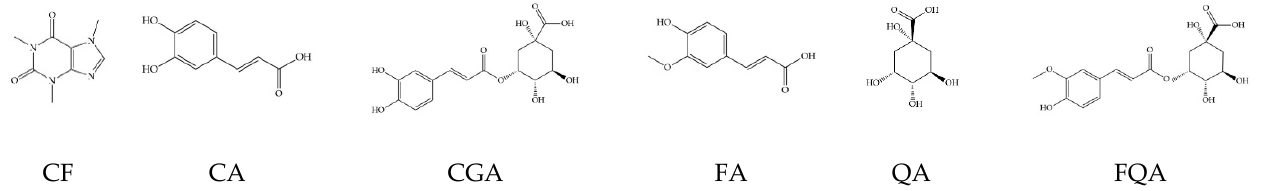
Figure 1. Chemical structures of caffeine (CF), caffeic acid (CA), chlorogenic acid (CGA), ferulic acid (FA), quinic acid (QA), and feruloylquinic acid (FQA) present in coffee [2].